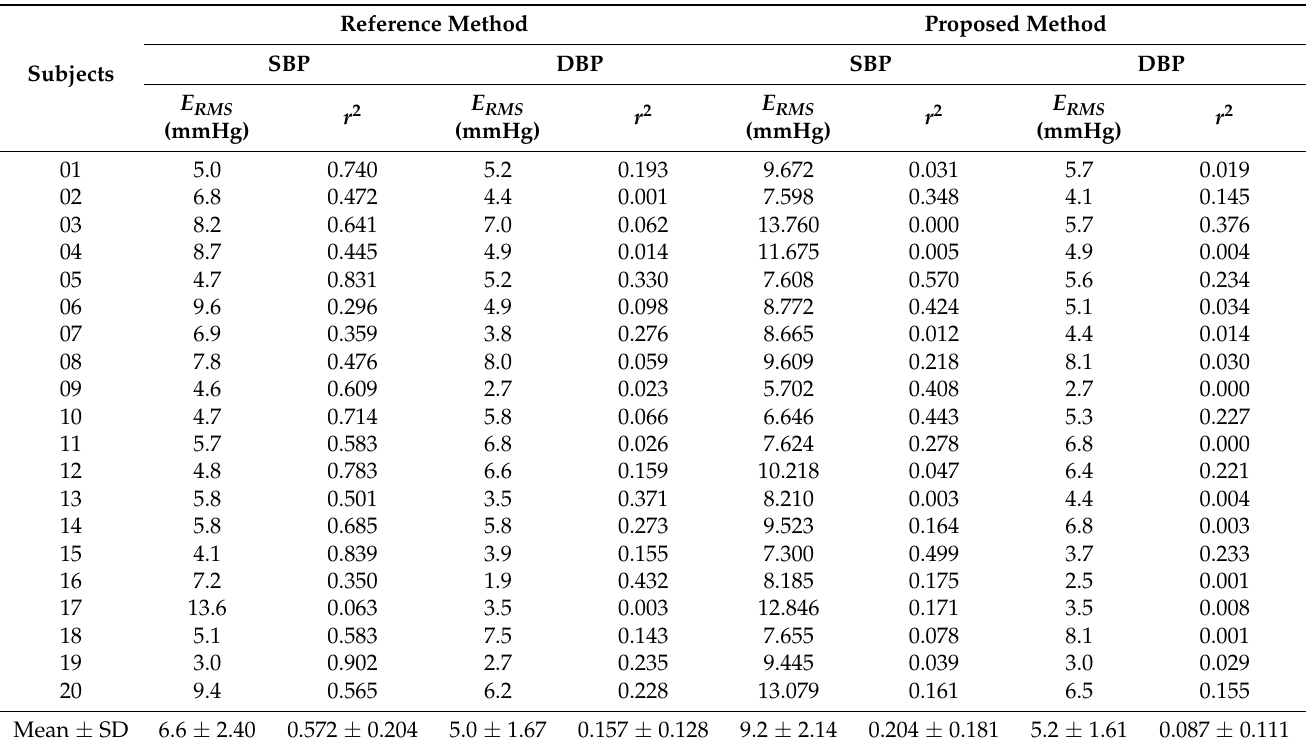
Table 2. The results of estimated systolic and diastolic blood pressures with Equation